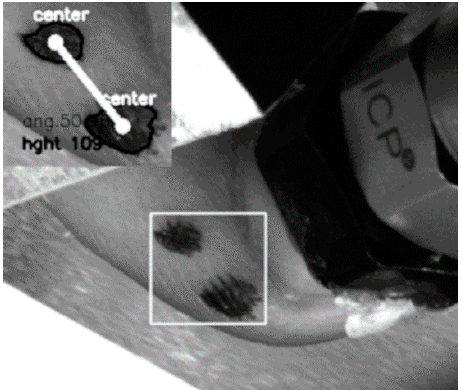
Figure 2. Image of a human finger in the measurement stand, while it was recorded by the camera-system. The white rectangle marks the area of the two dots used to evaluate the finger to surface angle. The inlet shows indicators for monitoring the angle. Abbreviations: ang—angle and hght—height. The height parameter is not evaluated in this study. On top of the fingernail the vibrational sensor can be seen.